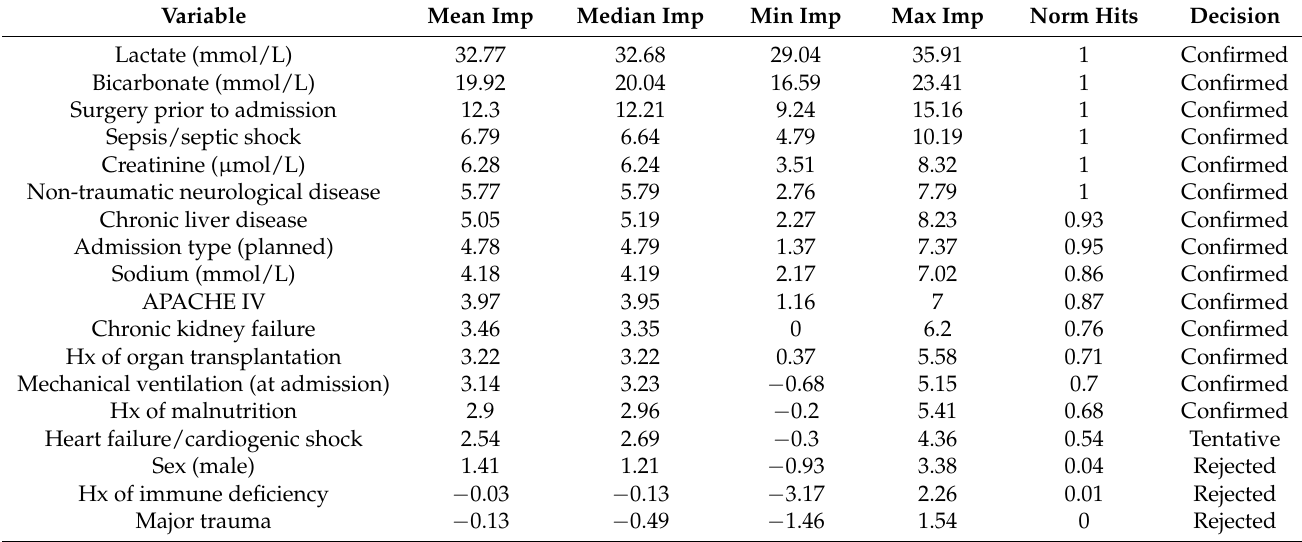
Table 2. Important Variable Selection with Boruta